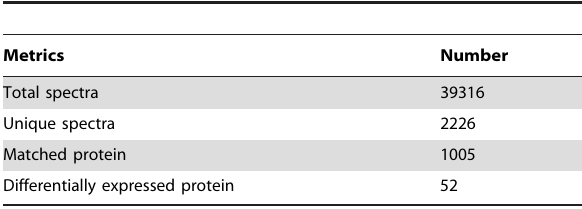
Table 2. Summary of iTRAQ metrics from B. tabaci proteomes.